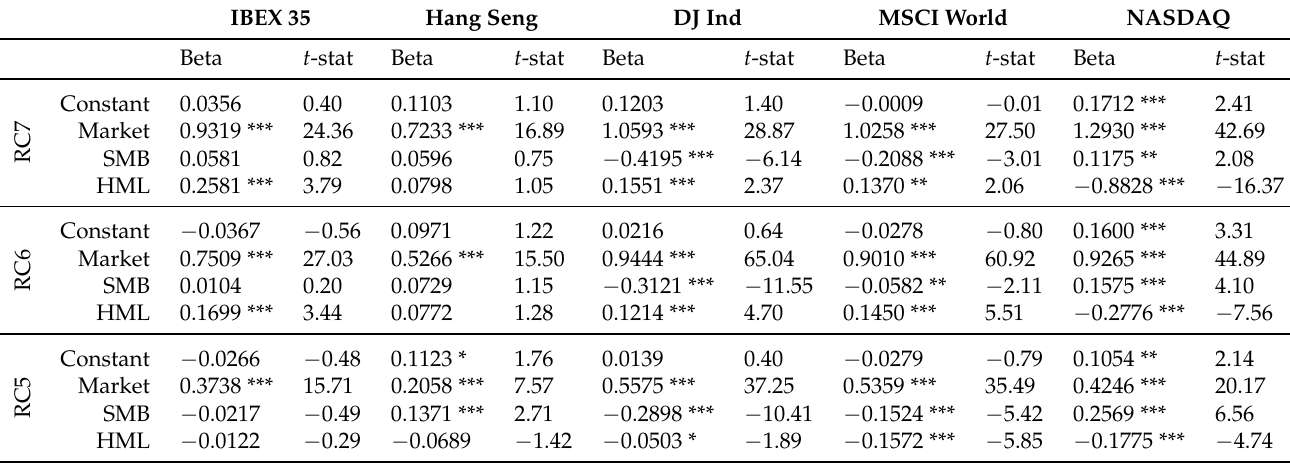
Table 5. This table shows the second set of results of the Fama–French three-factor regressions that were performed to verify if the volatility-based strategies yielded significant outperformance. Significance at a confidence level of 99%, 95%, 90% is indicated with ***, **, *, respectively. Apart from the NASDAQ, no significant alphas at the 99%-level could be